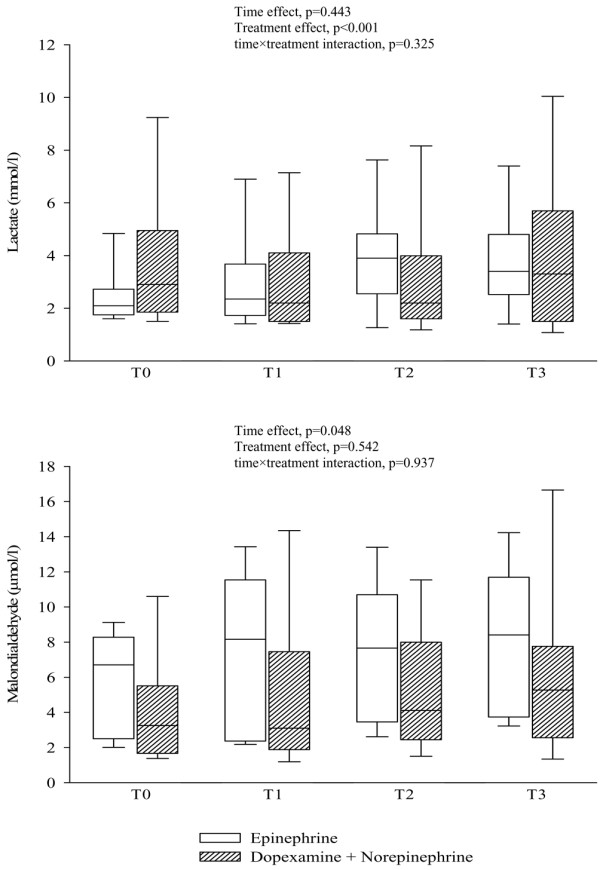
Evolution of arterial lactate and malondialdehyde concentrations. T0, just before catecholamine infusion; T1, as soon as mean arterial pressure reached 70 to 80 mmHg; T2, 2 hours after T1; T3, 6 hours after T1. Data are presented as boxplots.